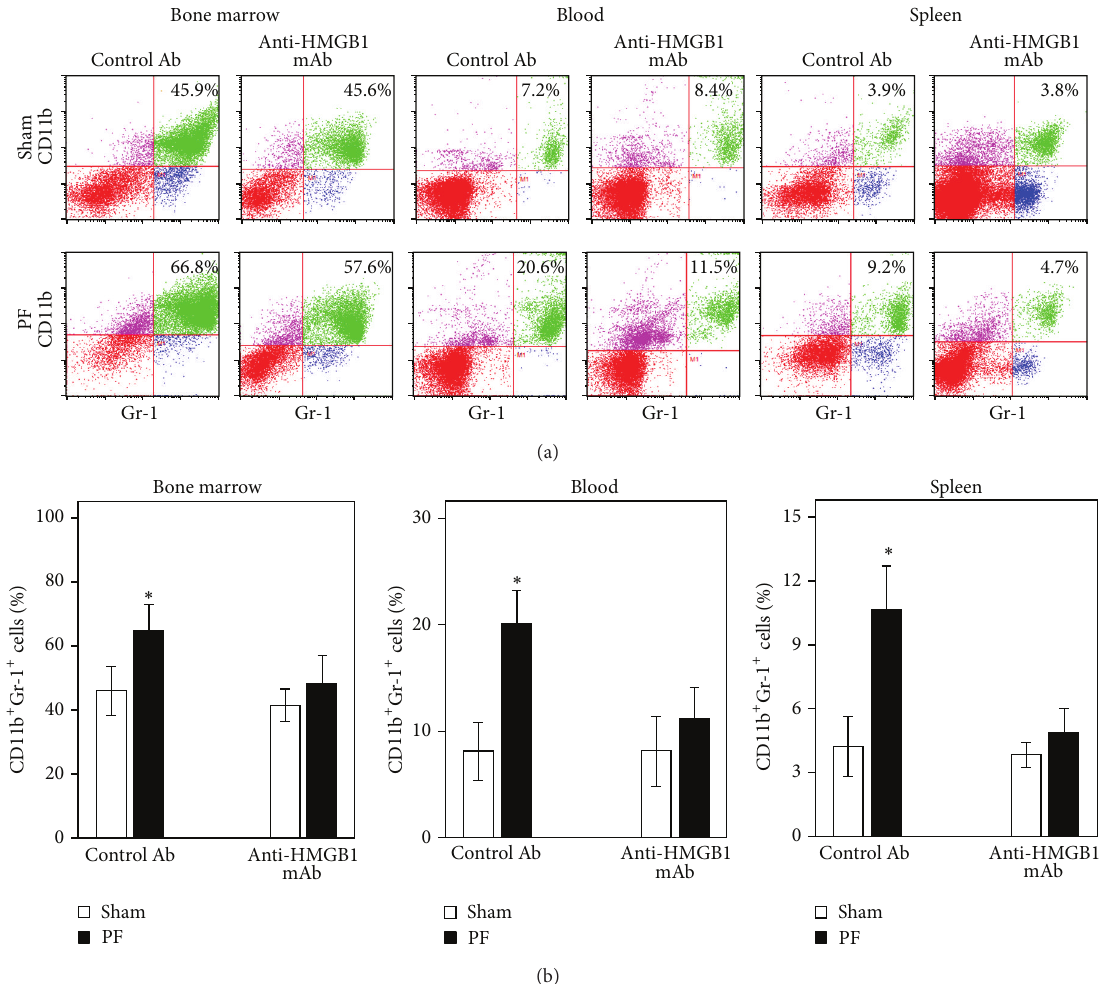
Figure 4: Anti-HMGB1 neutralizing mAb attenuates the expansion of CD11b + Gr-1 + MDSCs at 48h after pseudofracture (PF). (a) Representative flow cytometric analysis and (b) graphic analysis of CD11b + Gr-1 + cell frequencies in bone marrow, blood, and spleen in control and anti-HMGB1 Ab-treated mice at 48h after PF. ∗ 𝑃 < 0.05 versus corresponding uninjured control mouse group. Data represent means ± SEM; 𝑛 = 6 –8 mice per time